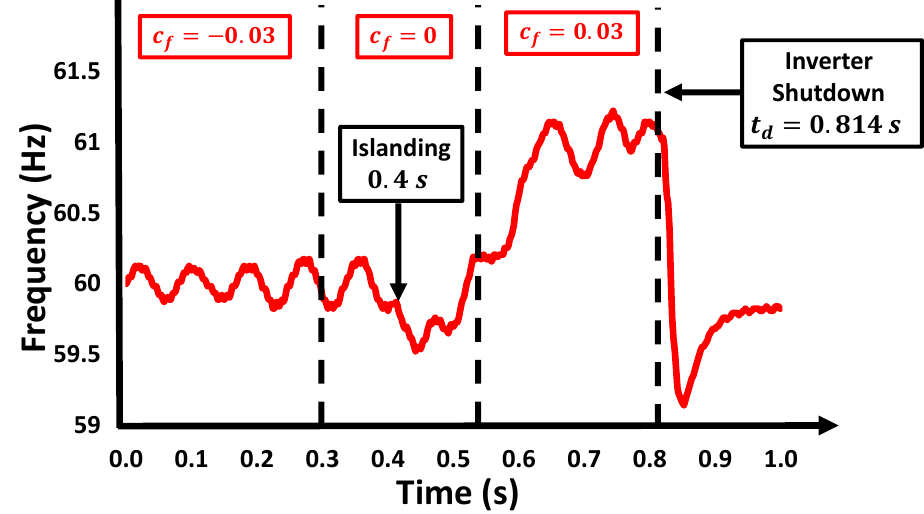
= = 1 . Figure 23. Frequency behavior after the AFDPCF for C norm 𝑛𝑜𝑟𝑚